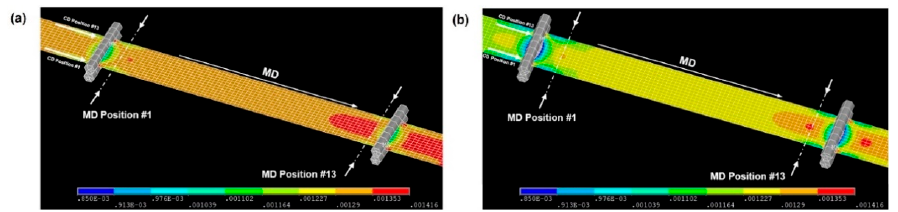
Figure 16. Strain distributions of the ( a ) PET and ( b ) PI films.